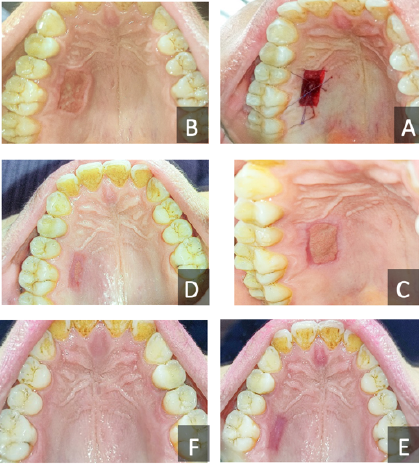
Figure 2. Palatal wound healing for Group I: (A) Day 0, (B) Day 7, (C) Day 14, (D)